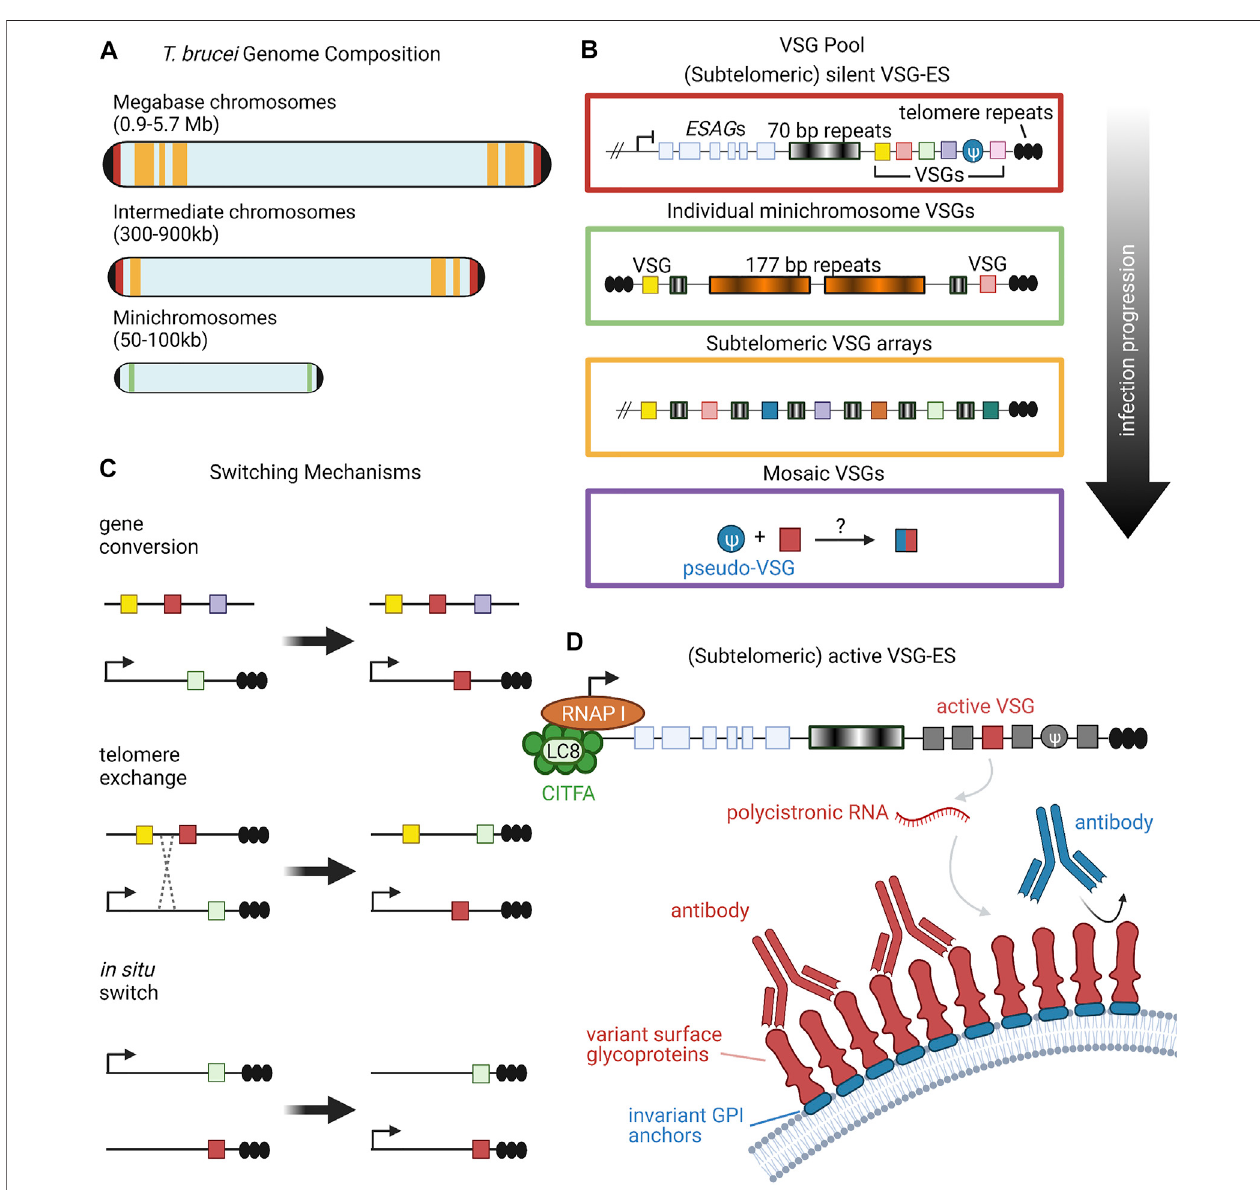
FIGURE 1 | Organization and Expression of VSGs. (A) T. brucei has an unusual karyotype consisting of large, megabase-sized chromosomes, intermediate chromosomes, and minichromosomes. Size ranges of each chromosome type are listed in parentheses (Berriman et al., 2005). Black caps on the ends of the chromosomesrepresenttelomeres.Red,yellow,andgreenbandsdenotethetypicallocationsofdifferentVSGrepertoires,correspondingtothecolored-codedinsetsin panel (B) . (B) Candidate VSG genes are located on megabase and intermediate chromosomes within silent subtelomeric bloodstream expression sites (VSG-ES; red box)orsubtelomericarrays (yellowbox).IndividualVSG genescanalso befoundinsubtelomericregionsofminichromosomes(green box)orcanbegeneratedfrom recombinationofintactand/orVSGpseudogenesfromvarioussources(purplebox).Throughoutthecourseofinfection, T.brucei willdrawupontheVSGpoolinasemi- predictable manner according to the location of candidate genes; for example, VSG gene arrays from silent expression sites are typically used before minichromosome VSGs (Sima et al., 2019). (C) VSG expression proceeds from a single active expression site. To shift expression to a new VSG gene, T. brucei can employ one of three switchingmechanisms:geneconversion,telomereexchange,or insitu switching(Liuetal.,1983;Rudenkoetal.,1996;HornandCross,1997;Robinsonetal.,1999;Li, 2015). (D) RNA polymerase I transcribes polycistronic RNAs from active VSG expression sites. The CITFA transcription factor complex, which in T. brucei consists of CITFAsubunits1 – 7(greencircles)complexedwithLC8/DYNLL1(lightgreenoval),isabasaltranscriptionfactorrequiredforRNApolIinitiation(Kirkhametal.,2016).The activeVSGgeneistypicallytranscribedlast,precededbyexpression-siteassociatedgenes(ESAGs)(Paysetal.,2001;Hertz-Fowleretal.,2008).VSGRNAistranslated into variant surface glycoproteins, which form a densely-packed coat that prevents recognition of underlying invariant cell-surface molecules, such as GPI anchors (Hertz-Fowler et al., 2008; Horn and McCulloch, 2010). Figure inspiration was drawn from various sources (Rudenko et al., 1996; Berriman et al., 2005; Li, 2015). All fi gures in this review were created using BioRender.